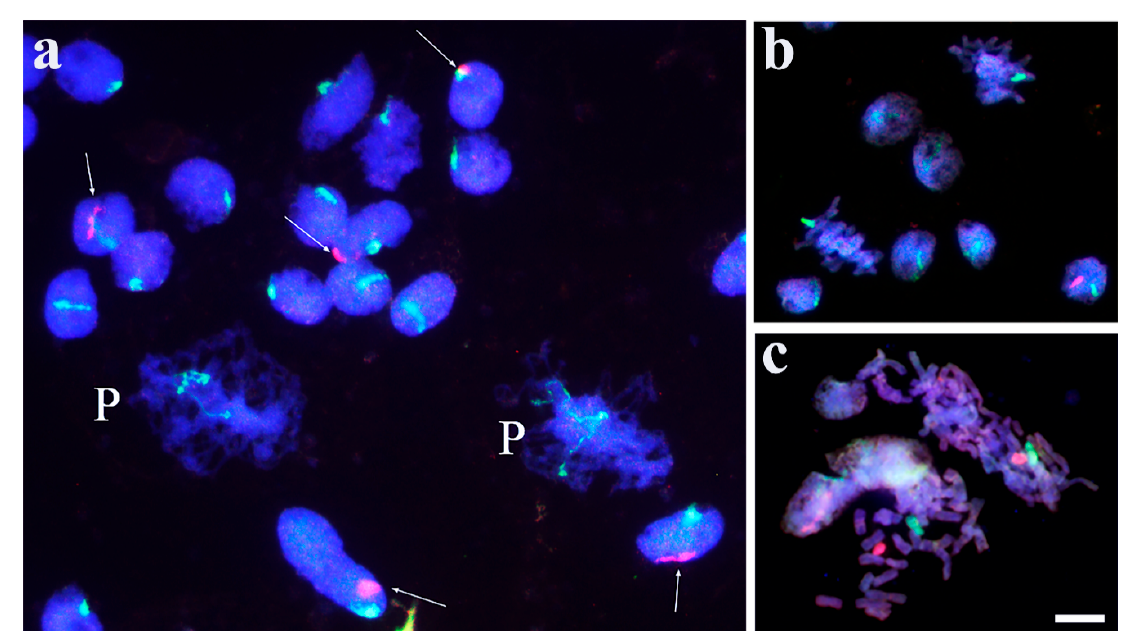
Figure 6. Mosaicism detected in the 7H v L5H ch double monosomic addition line in wheat in the absence of the Ph1 locus. Hordeum vulgare (red) and H. chilense (green) were visualised in meiotic ( a , b ) and somatic cells ( c ). DNA was counterstained with DAPI (blue). ( a ) Meiocytes in pachytene (P) showed only the H. chilense chromosome although somatic surrounding cells within the anther contained both H. vulgare and H. chilense chromosomes (arrowed). ( b ) Meiocytes in metaphase only showed the H. chilense chromosome. ( c ) Somatic cells from root tips in interphase and metaphase showed both barley chromosomes in all cells. Bar: 10 µm.